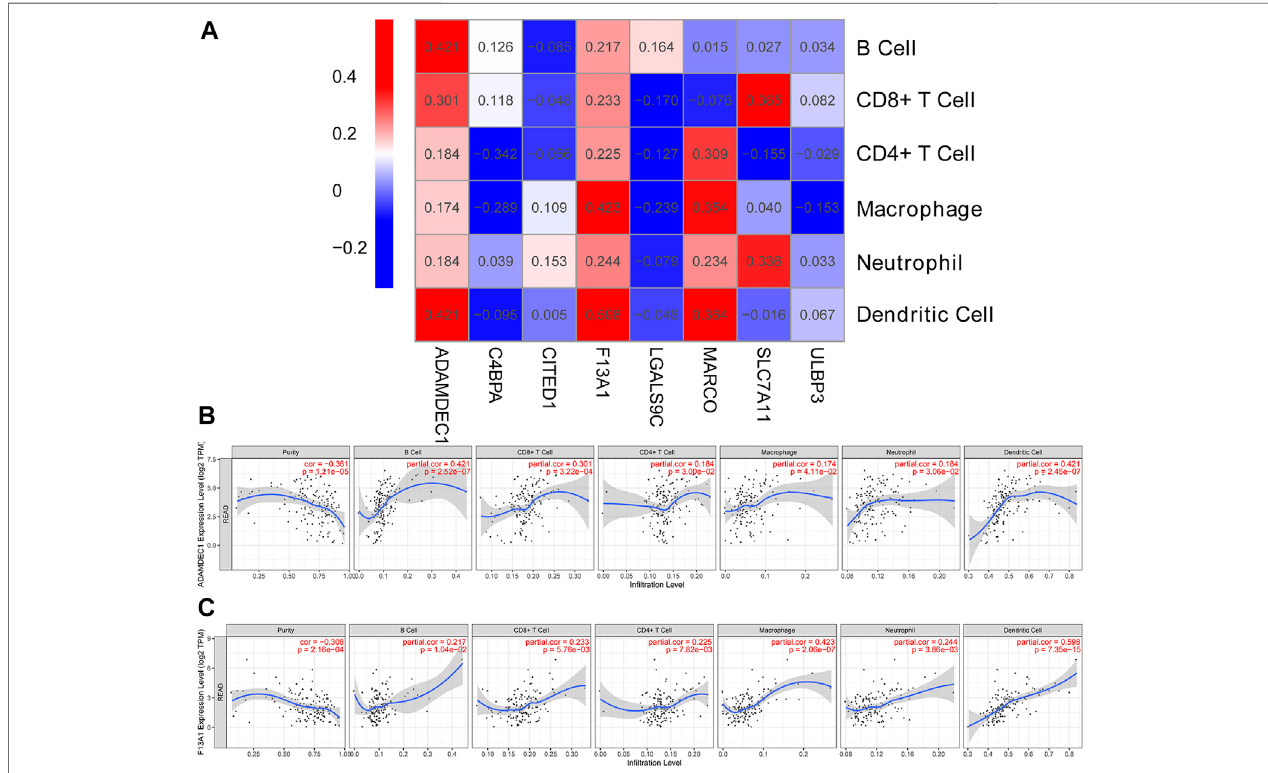
FIGURE 3 | Correlation heatmap between DEGs and immune in fi ltration cells. (A) Heatmap of the correlation between DEGs and immune in fi ltration cells. (B,C) Scatter plots of the correlation between immune in fi ltration cells and ADAMDEC1 and F13A1 expression levels, respectively.